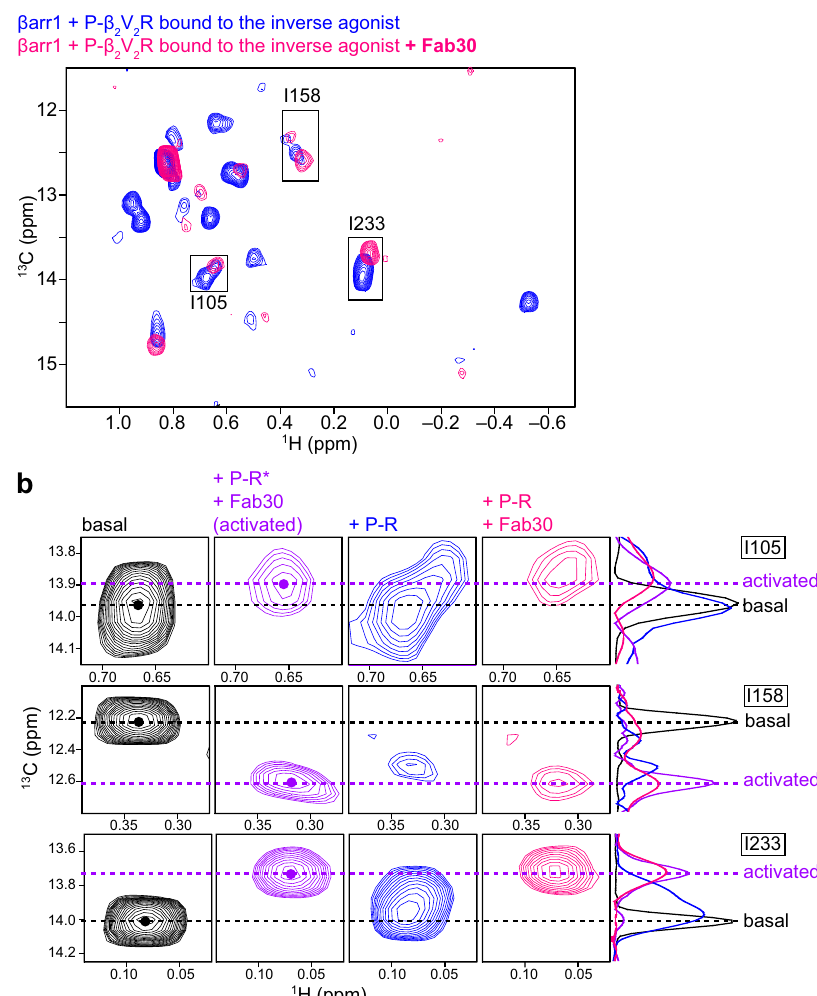
Fig. 4 Effects of Fab30 on the β arr1 conformation in complex with phosphorylated β 2 V 2 R bound to the inverse agonist. a Overlay of the 1 H- 13 C HMQC spectra of [u- 2 H, Ile δ 1- 13 C 1 H 3 ] β arr1 in the complex with phosphorylated β 2 V 2 R in rHDLs bound to the inverse agonist (blue) and in the complex with both phosphorylated β 2 V 2 R in rHDLs bound to the inverse agonist and Fab30 (pink). b Comparison of the resonances from the Ile δ 1 methyl groups of β arr1 in the basal state (black), in the complex with both phosphorylated β 2 V 2 R in rHDLs bound to the full agonist and Fab30 ( + P-R* + Fab30, purple), in the complex with phosphorylated β 2 V 2 R in rHDLs bound to the inverse agonist ( + P-R, blue), and in the complex with both phosphorylated β 2 V 2 R in rHDLs bound to the inverse agonist and Fab30 ( + P-R + Fab30, pink). The 13 C 1D projections of selected regions are shown on the right of the spectra. The 1D projection of the spectra corresponding to the basal state is reduced by a factor of fi ve, to compare the 13 C chemical shifts clearly. The 13 C chemical shifts corresponding to the basal and activated conformations are indicated by dashed